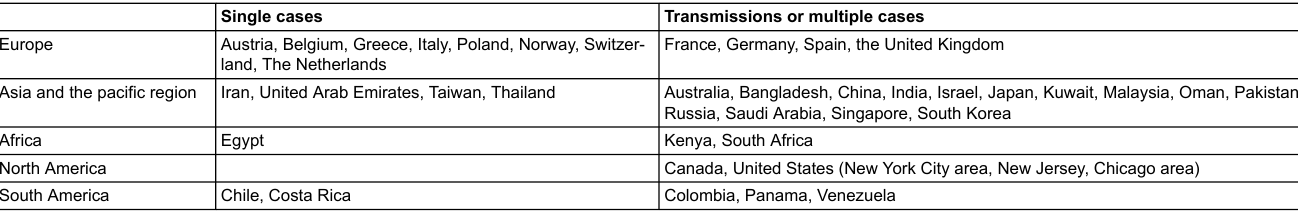
Table 1: Countries from which C. auris cases have been reported (data as of 31 December 2019 [21]). Single